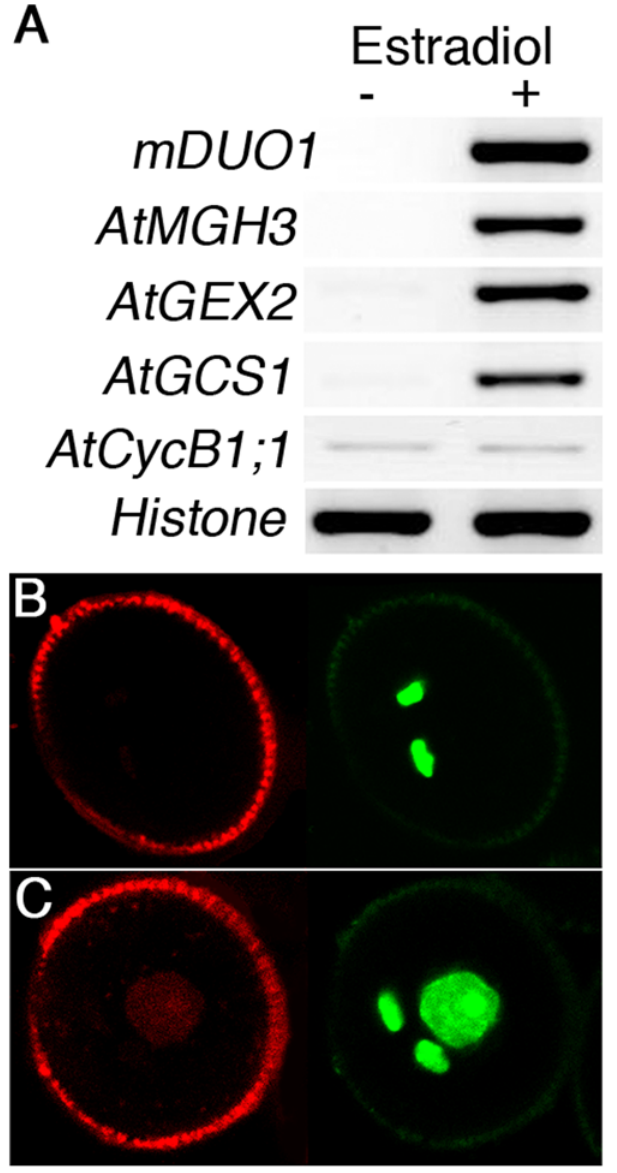
Figure 2. Ectopic expression of DUO1 results in expression of male germline specific genes. (A) RT-PCR analysis of mDUO1 , AtMGH3 , AtGEX2 , AtGCS1 and AtCycB1;1 expression in whole seedlings transformed with the mDUO1 cDNA (see methods) under the control of an estradiol inducible promoter grown on media without estradiol ( 2 ) or with estradiol ( + ). Histone H3 was used as a control. (B, C) Mature pollen grains showing AtMGH3-H2B::GFP expression specifically in sperm cells in the absence of LAT52-DUO1::mRFP (B), or in both the vegetative cell nucleus and sperm cells in the presence of LAT52- DUO1::mRFP (C). Left and right panels correspond to RFP and GFP signals viewed by CLSM.